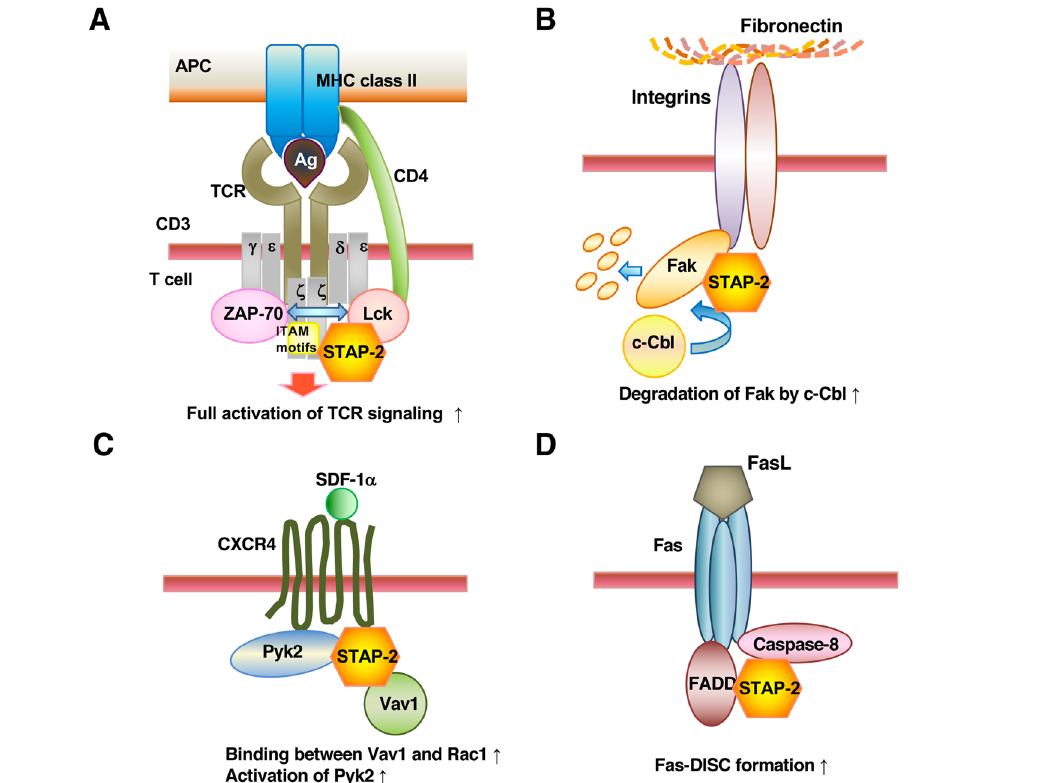
Figure 2. STAP-2 modulates T-cell functions through interaction with individually unique signaling molecules. STAP-2 can modulate (A) TCR-, (B) integrin-, (C) chemokine-, or (D) Fas-mediated signals as illustrated. APC: antigen-presenting cell; Ag: antigen; CXCR4: C-X-C motif chemokine receptor 4; Fas-DISC: Fas-death-inducing signaling complex; FADD: